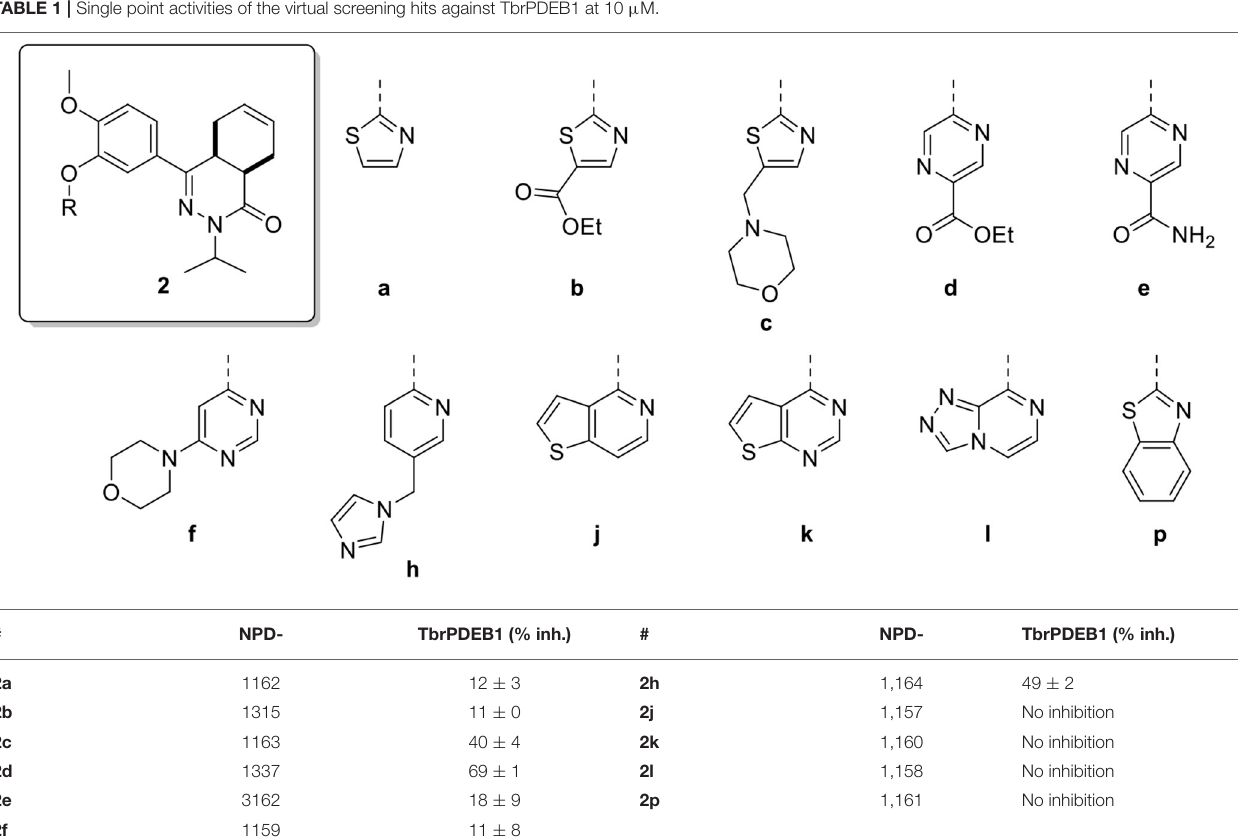
TABLE 1 | Single point activities of the virtual screening hits against TbrPDEB1 at 10 µ